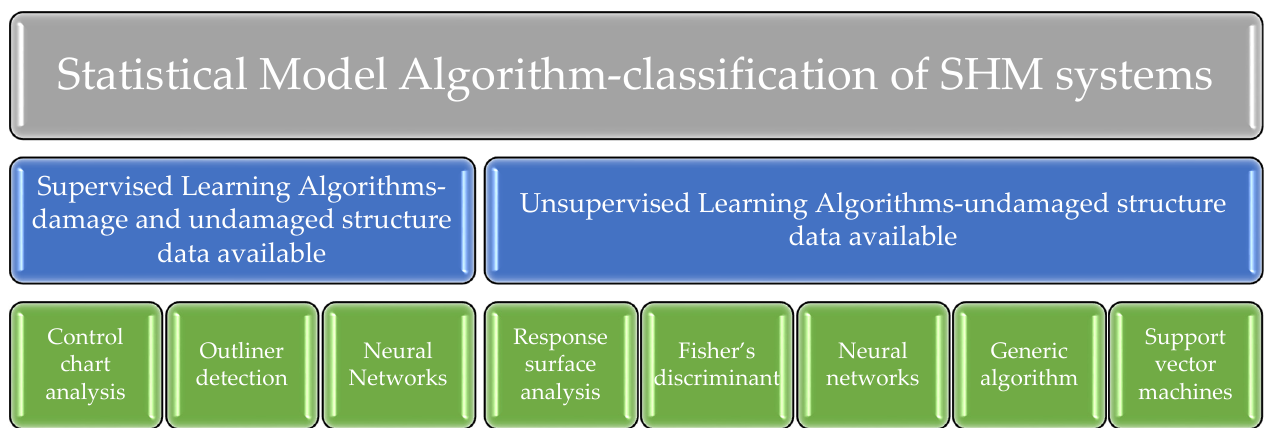
Figure 4. Algorithms classification for Statistical Model Development for SHM.